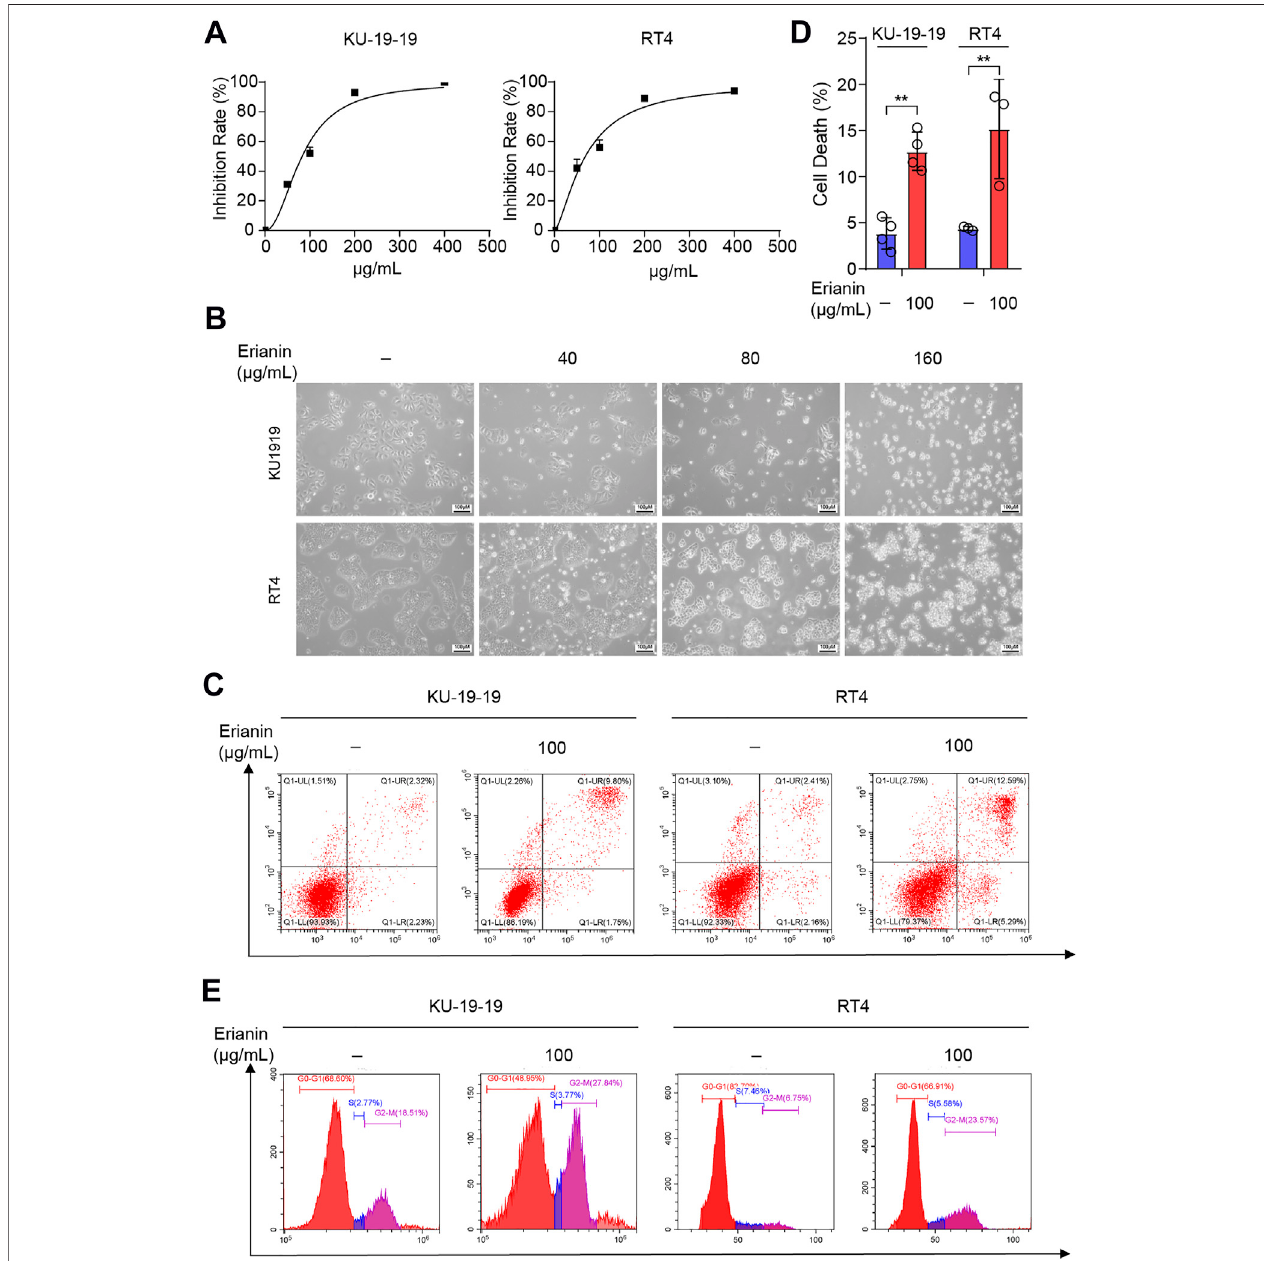
FIGURE 1 | Erianin inhibited cell proliferation and triggered cell death in bladder cancer cells. (A) Cell proliferation of KU-19 – 19 and RT4 was assessed by CCK-8 assay after the treatment with different dose of erianin treatment for 24 h. (B) The cell morphology was observed by microscope. (C,D) Flow cytometry analysis of cell deathbyAnnexinV-FITC/PIstaininginKU-19 – 19andRT4cellsweretreatedwitherianinorDMSOcontrolfor24 h,andthequanti fi cationofpercentage ofthecelldeath was shown. * p < 0.05,** p < 0.01. (E) The percentage of cells treated with erianin in each phase was assessed by fl ow